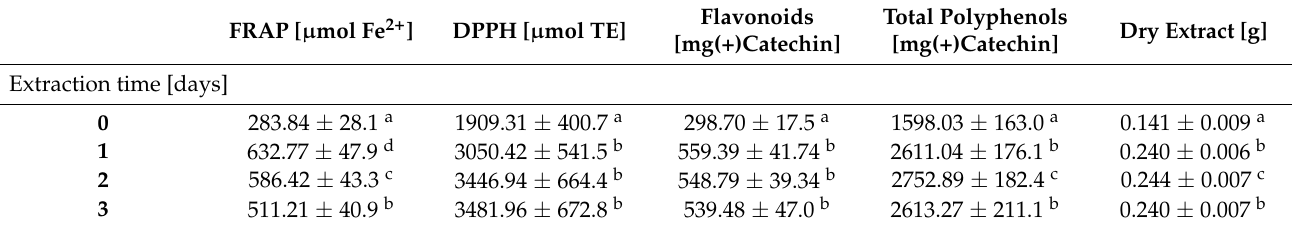
Table 2. The influence of the extraction time on the antioxidant properties of the elderflower extracts (FRAP, DPPH), the total contents of flavonoids and polyphenols, and the content of the dry extract in grams (SE ± , n = 96).